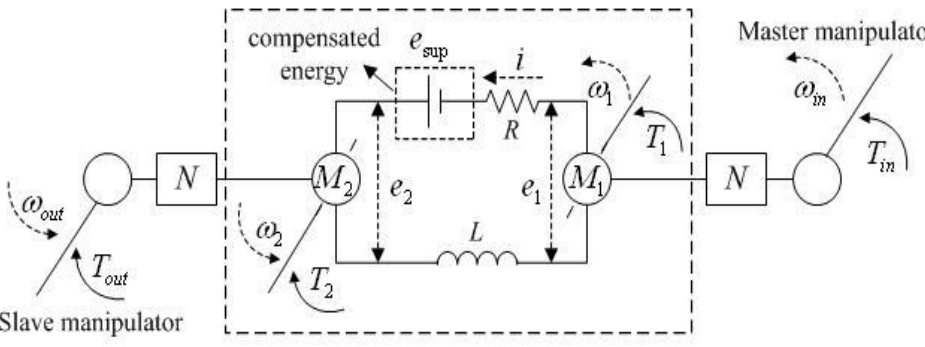
Figure 1. Equivalent circuit of the master-slave control